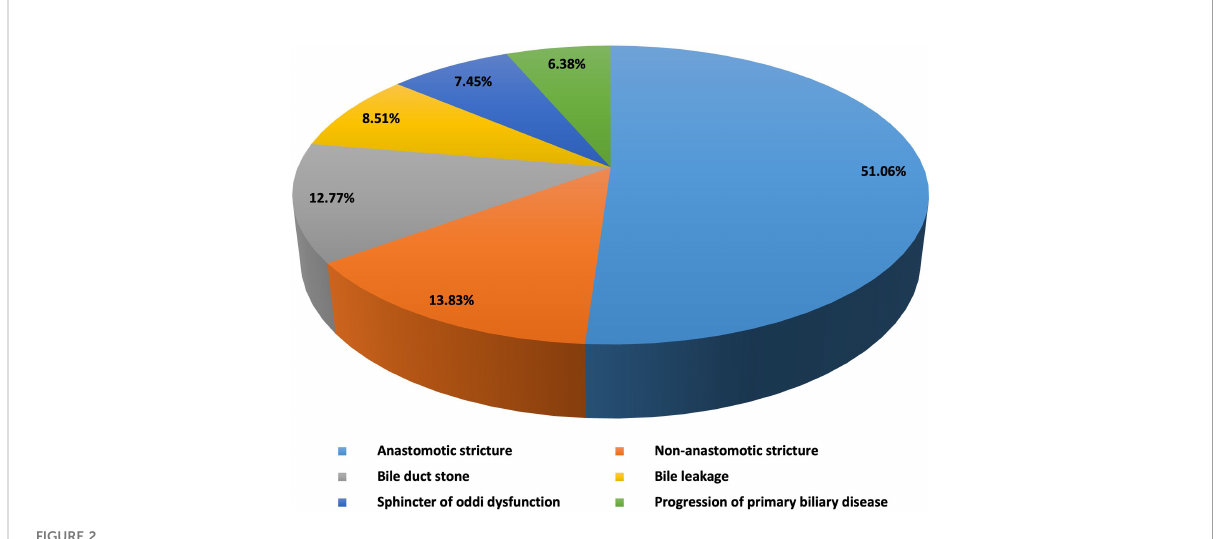
FIGURE 2 Baseline characteristics (etiology) of included